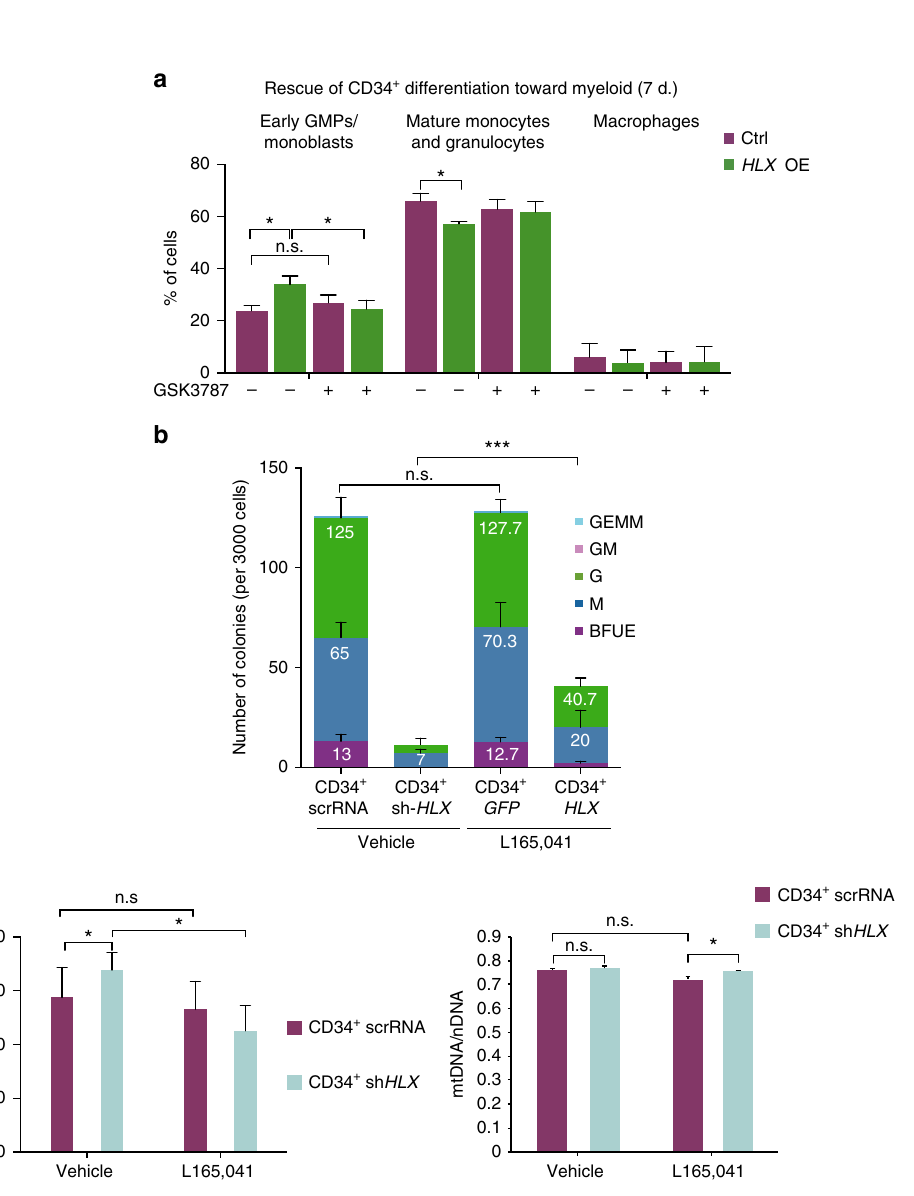
Fig. 6 Metabolic role of HLX in human CD34 + cells. a Average number of colonies in CFU-C assays performed in CD34 + cells infected with control scrRNA or sh- HLX (left panel) or in CD34 + cells overexpressing GFP (CD34 + GFP ) or HLX (CD34 + HLX ) (right panel) ( n = 3, three technical replicates each time, mean + s.d., Student ’ s t- test, * P < 0.05, **** P < 0.0001). GEMM Granulocyte, Erythrocyte, Monocyte, Megakaryocyte, GM Granulocyte, Macrophage, G Granulocyte, M Macrophage, BFUE Burst-forming unit-erythroid. b Representative images of GEMM, BFUE, and M colonies from CFU-C assays in CD34 + GFP or CD34 + HLX cells. Scale bar: 50 µ M. c Flow cytometric analysis representing elevated numbers of immature myeloid cells in CD34 + HLX cells differentiated toward the myeloid lineage for 7 days ( n = 3 + s.d., Student ’ s t- test, * P < 0.05, ** P < 0.01). d Heatmap representing the fold change of selected genes from RNA-Seq of CD34 + sh- HLX and CD34 + HLX cells compared to their respective controls. e Oxygen consumption rate in CD34 + GFP or HLX cells before differentiation ( n = 3, mean + s.d.). f Mitochondrial membrane potential measured by TMRM in CD34 + GFP or CD34 + HLX cells (left panel) ( n = 6, mean + s.d., Student ’ s t -test, *** P < 0.001) and the corresponding mitochondrial vs. nuclear DNA ratio (right panel) ( n = 3, mean +